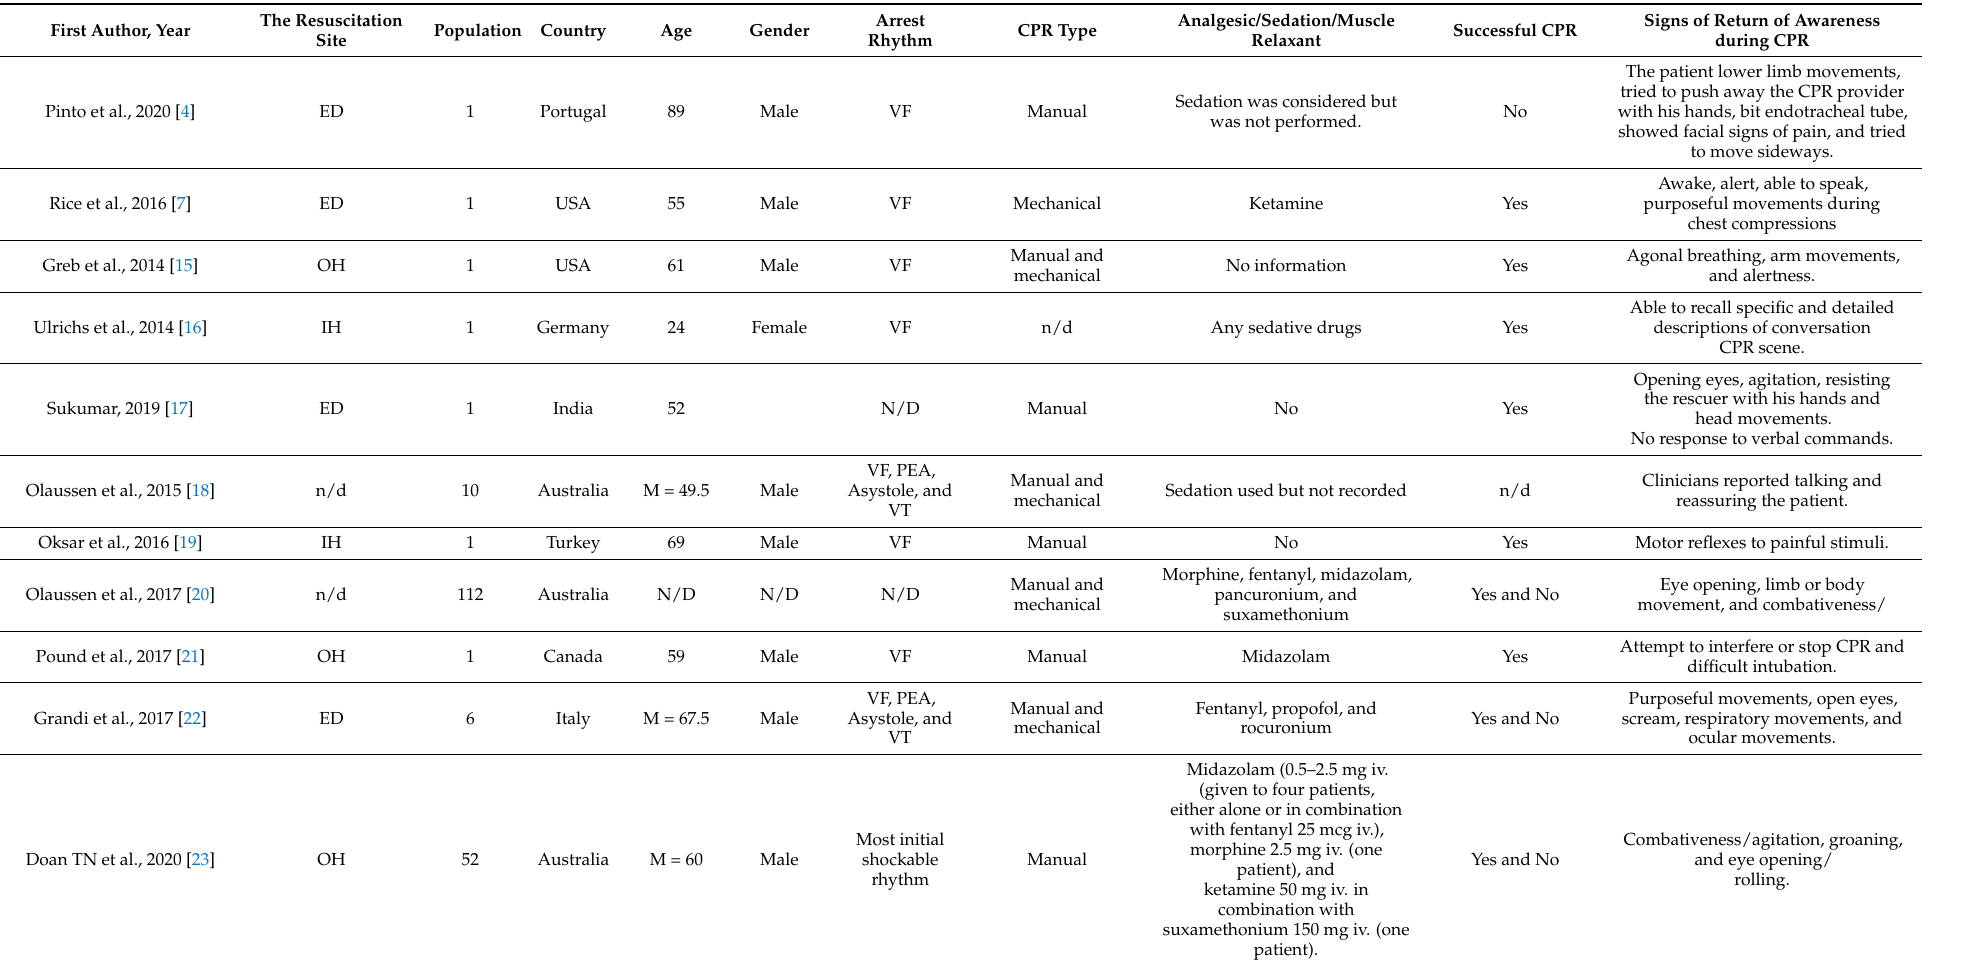
Table 2. Return of consciousness during cardiopulmonary